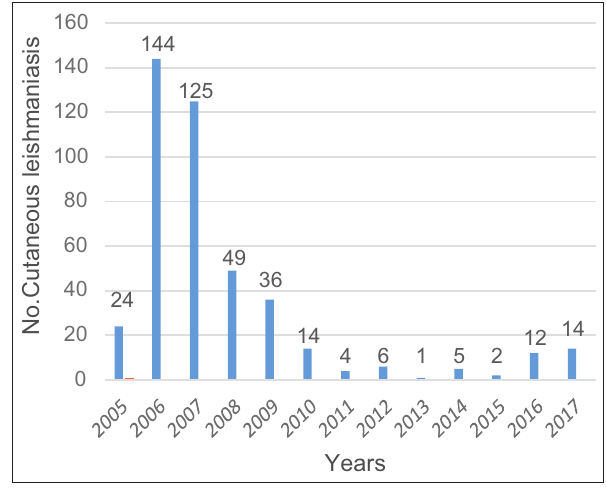
Annually reports of human cutaneous leishmaniasis cases in Tangestan County, Bushehr Province (2005-2017).